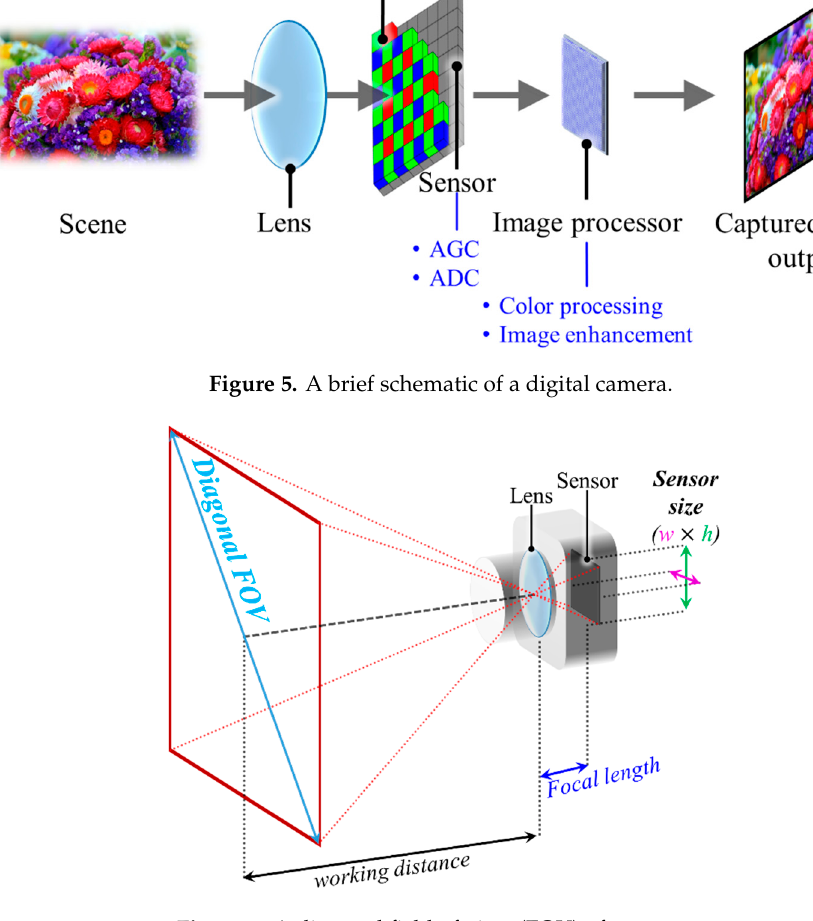
Figure 6. A diagonal field of view (FOV) of a camera.